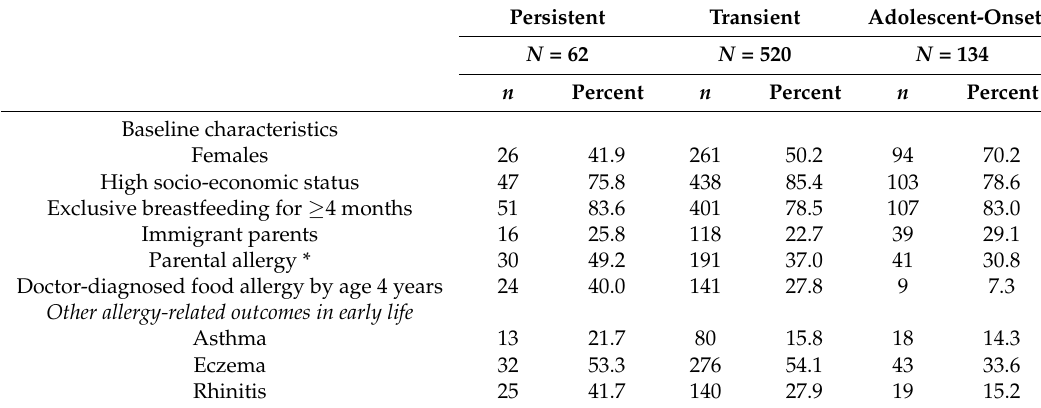
Figure 1. Prevalences of milk- related symptoms by gender in early life (to age 4 years) and at ages 8 and 16 years, including timing of onset (persistent *, transient † and adolescent-onset ‡) of milk- related symptoms ( N = 2819). ( A ) Early life and ages 8 and 16 years; ( B ) Timing of onset. * Milk-related symptoms in early life and/or at age 8 years and at age 16 years; † Milk-related symptoms in early life or at 8 years, but not at age 16 years; ‡ Milk-related symptoms at 16 years, but not in early life or at 8 years; § p < 0.002 vs. the opposite sex at the corresponding time point. Table 3. Descriptive information of participants with persistent vs. transient vs. adolescent-onset milk-related symptoms ( N = 716).